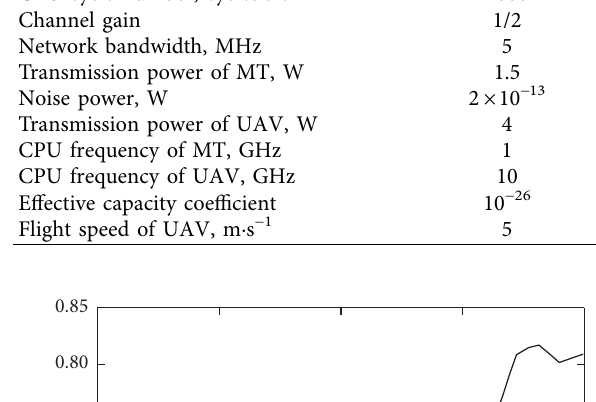
Figure 6: The relationship between the number of tasks and the average time delay under different numbers of